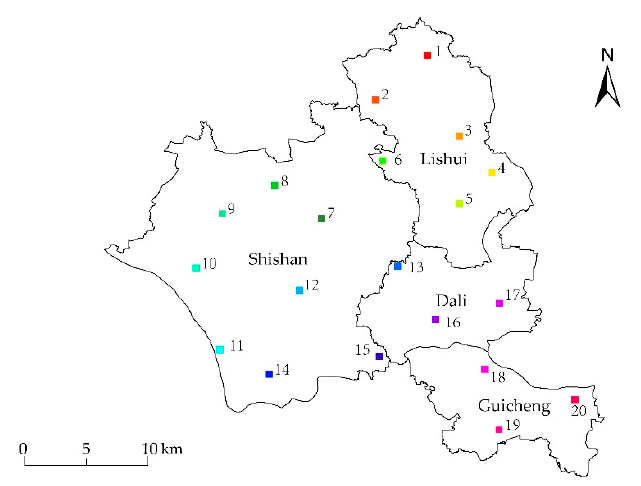
Figure 4. Distribution of the validation samples.